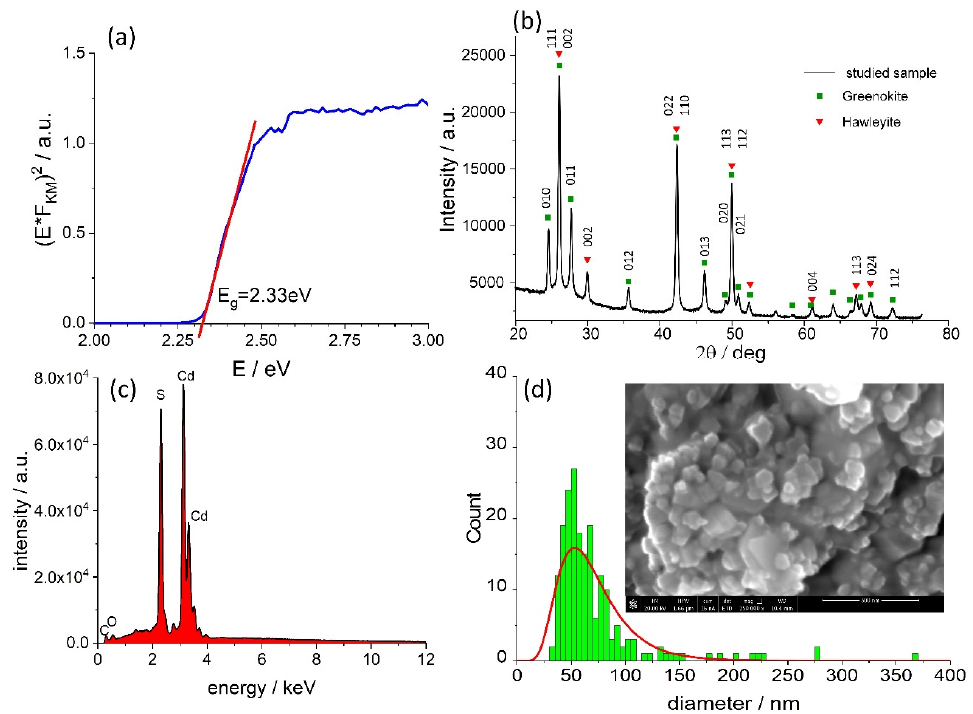
Figure 1. The Tauc plot ( a ), the powder X-ray diffractogram ( b ), the energy-dispersice X-ray spectrum (EDS) ( c ) and the crystallite diameter distribution of the CdS sample ( d ) discussed in this study. Inset shows the SEM image of the studied sample.